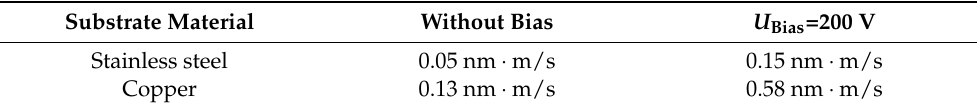
Table 1. Determined dynamic removal rates for the substrate materials stainless steel and copper in relation to bias